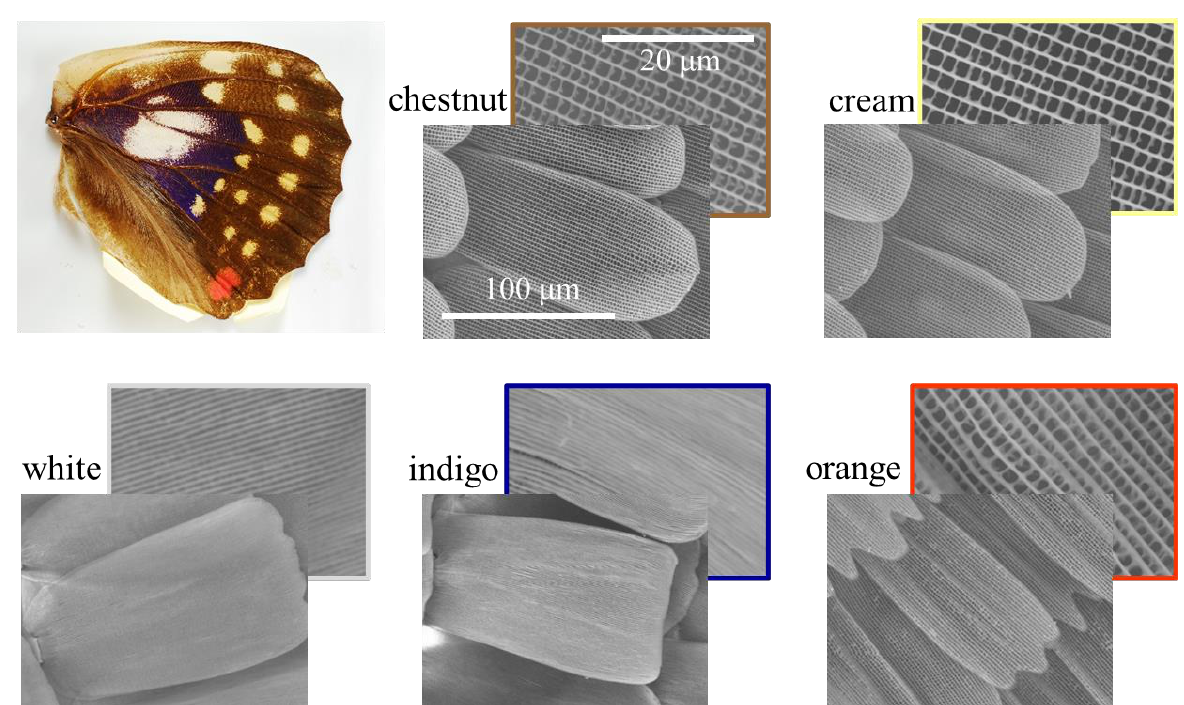
Figure 2. SEM images (Hitachi TM3000) of five types of scale from S. charonda as classified by coloration, corresponding to chestnut, cream, white, indigo, and orange scales. Images at lower magnification (scale bar: 100 µm) show the overall shape, and those at higher magnification (scale bar: 20 µm) reveal microstructures consisting of ridges and cross-ribs.